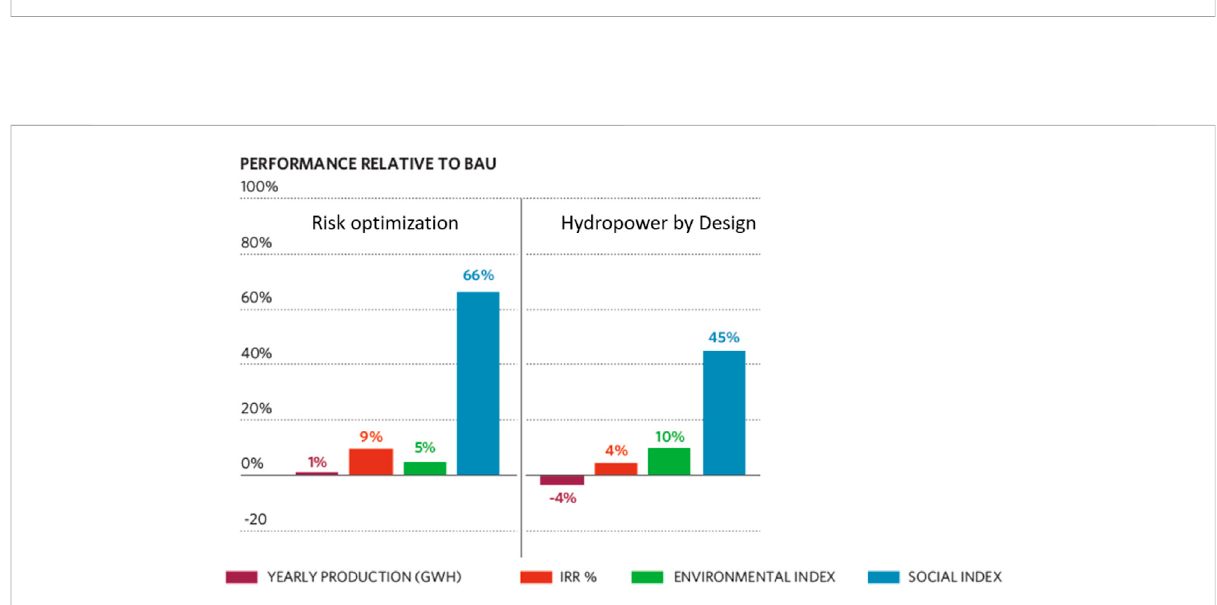
FIGURE 10 Performance relative to the BAU scenario for fi nancial, power, social and environmental metrics for the risk optimization scenario and the HbD scenario. Note that “ positive ” bars indicate improved performance relative to the BAU (e.g., a positive bar on “ environmental index ” indicates better environmental performance and reduced negative impacts on environmental